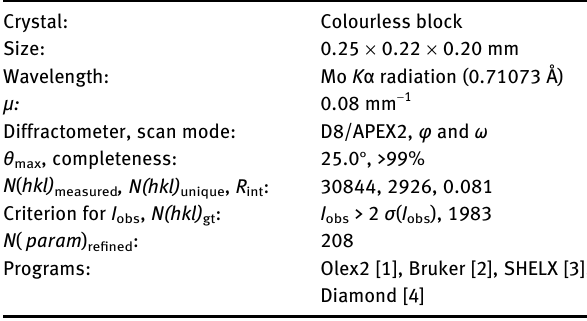
Table  : Data collection and